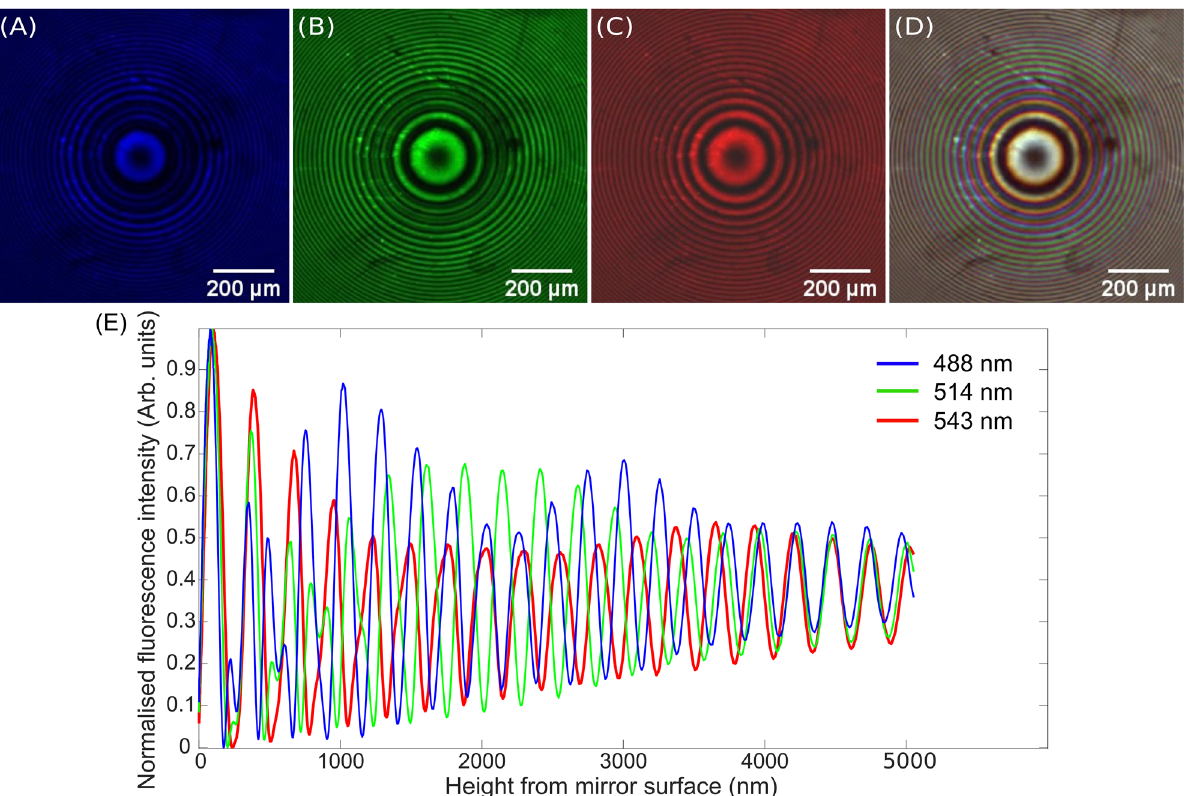
Figure 2. Single-excitation-wavelength SW images of a DiI coated f = 48 mm lens specimen obtained using excitation wavelengths of ( A ) 488 nm, ( B ) 514 nm and ( C ) 543 nm, which are pseudo-coloured blue, green and red respectively, and ( D ) shows the RGB composite of 2 ( A – C ) which is the TartanSW image. The lens specimen was placed on a mirror (Laser 2000) and was imaged using a Leica SP5 confocal microscope with a 5×/0.15 N.A. HCX PL FLUOTAR DRY objective. Images were 2048 × 2048 pixels in size, and were averaged over 3 frames at a line speed of 100 Hz, with an emission detection bandwidth of 550–650 nm. The scale bar for images ( A – D ) is 200 µm. ( E ) Normalized intensity profiles of the lens specimen from ( A – C ) computed using the custom MATLAB code for excitation wavelengths of 488 nm (blue), 514 nm (green) and 543 nm (red). As expected, the